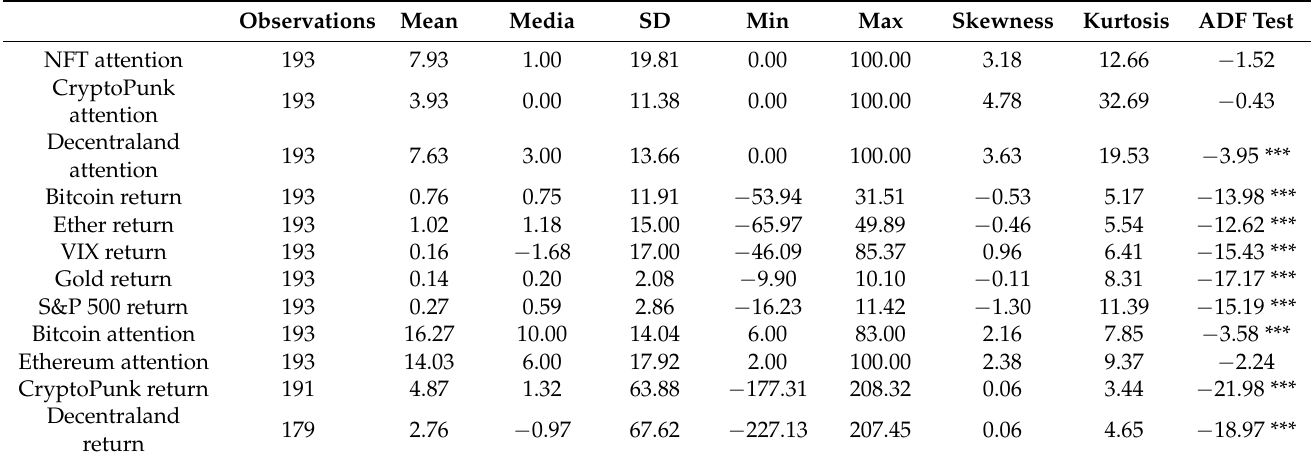
Table 1. Descriptive statistics of key